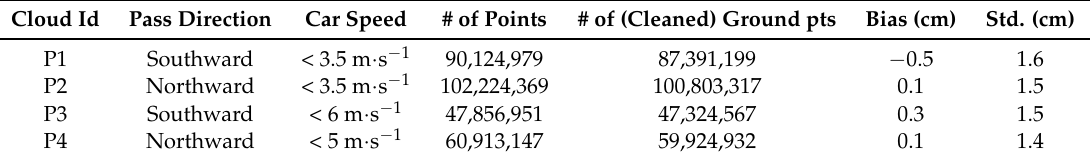
Table 1. Number of raw and cleaned ground points for individual passes with associated survey speed and direction; last two columns are the mean and standard deviation of the differences between individual DEM for each pass and the reference DEM.